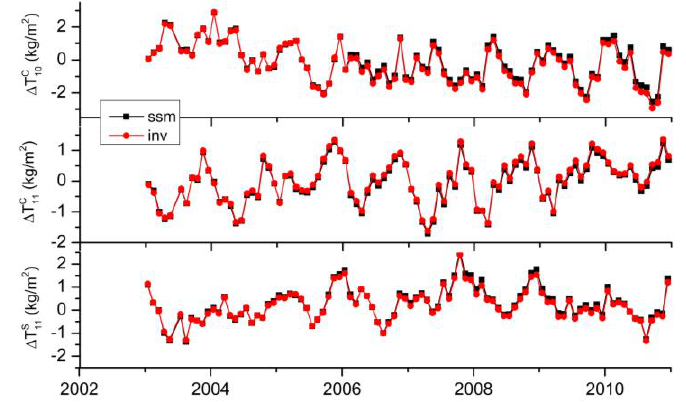
Figure 6. Aliasing errors of unresolved higher degrees in degree-1 coefficients calculated by the SSM approach ( black ); Differences between inverted degree-1 coefficients and the reference values ( red ). More than 99% of the ‘inv’ ( red ) variance is explained by ‘ssm’ ( black ).